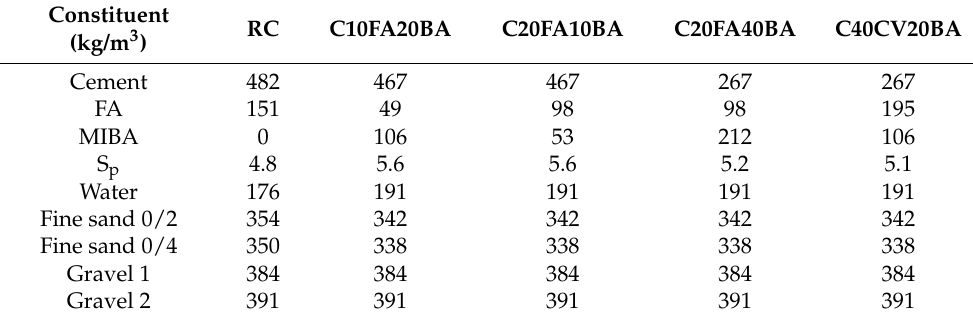
Table 1. Composition of